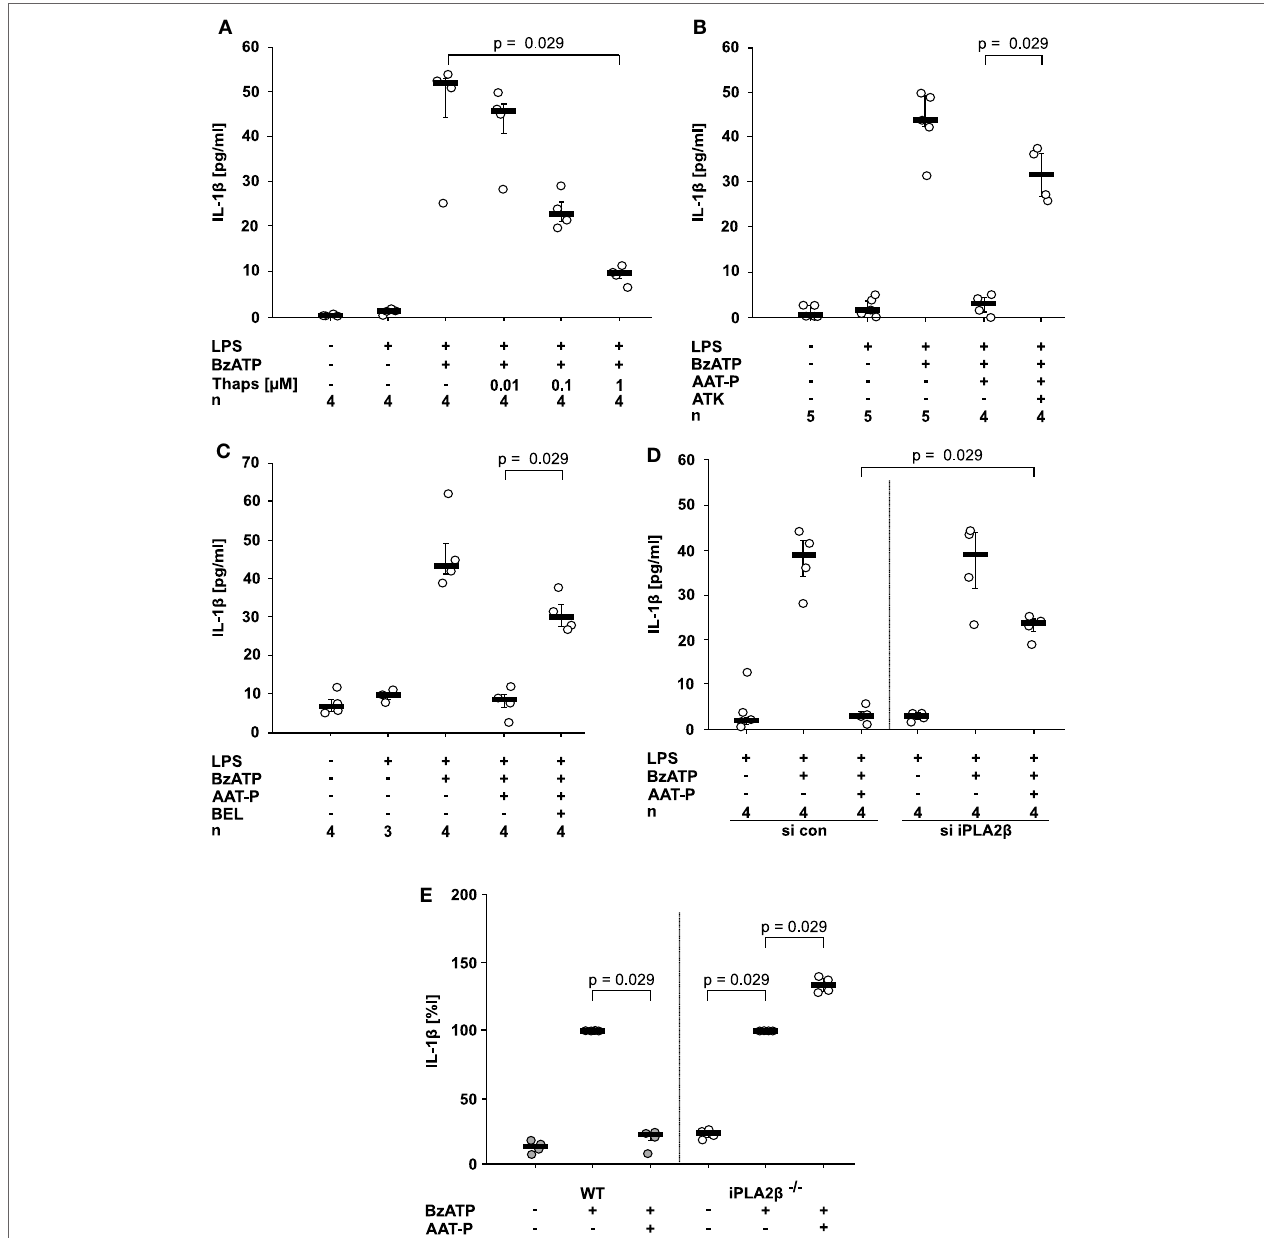
FigUre 4 | Alpha-1 antitrypsin (AAT) signaling involves activation of calcium-independent phospholipase A2 β (iPLA2 β ). (a–D) Lipopolysaccharide (LPS)-primed U937 cells were stimulated with 2 ′ (3 ′ )- O -(4-Benzoylbenzoyl)adenosine-5 ′ -triphosphate (BzATP) in the presence or absence of Prolastin ® (AAT-P, 1 mg/ml). Interleukin (IL)-1 β released to the supernatant was measured after 30 min. Different doses of thapsigargin (a) , the unselective PLA2 inhibitor arachidonyl trifluoromethyl ketone [ATK, (B) ] or the preferential iPLA2 β inhibitor bromoenol lactone [BEL, (c) ] were added together with BzATP and AAT-P. (D) Expression of iPLA2 β by U937 cells was silenced by siRNA (si iPLA2 β ). In addition, cells were transfected with control siRNA (si con). U937 cells transfected with si con or with si iPLA2 β were primed with LPS and the release of IL-1 β was stimulated by BzATP. (e) Adherent peripheral blood mononuclear cells were isolated from wild type (WT) or iPLA2 β gene-deficient mice (iPLA2 β − / − ) and stimulated with BzATP in the absence or presence of AAT-P. IL-1 β released in response to BzATP was normalized to 100%. Data are presented as individual data points, bar represents median, whiskers encompass the 25th to 75th percentile, n -numbers of independent experiments are indicated in the figure. Experimental groups were compared by Kruskal–Wallis test followed by Mann–Whitney rank sum